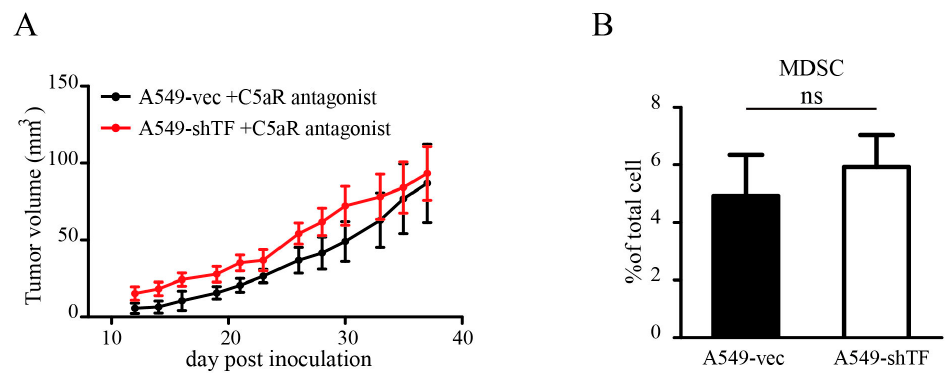
Figure 5. Effect of C5aR antagonism on tumor growth and MDSC recruitment. Tumor growth of A549-vec cells and A549-shTF cells injected subcutaneously in nude mice treated with a C5aR antagonist ( n = 5). Tumor volume ( A ) is expressed as mean ± SEM. Percentage of MDSC ( B ) in tumor is analyzed by flow cytometry, ns, no significance.